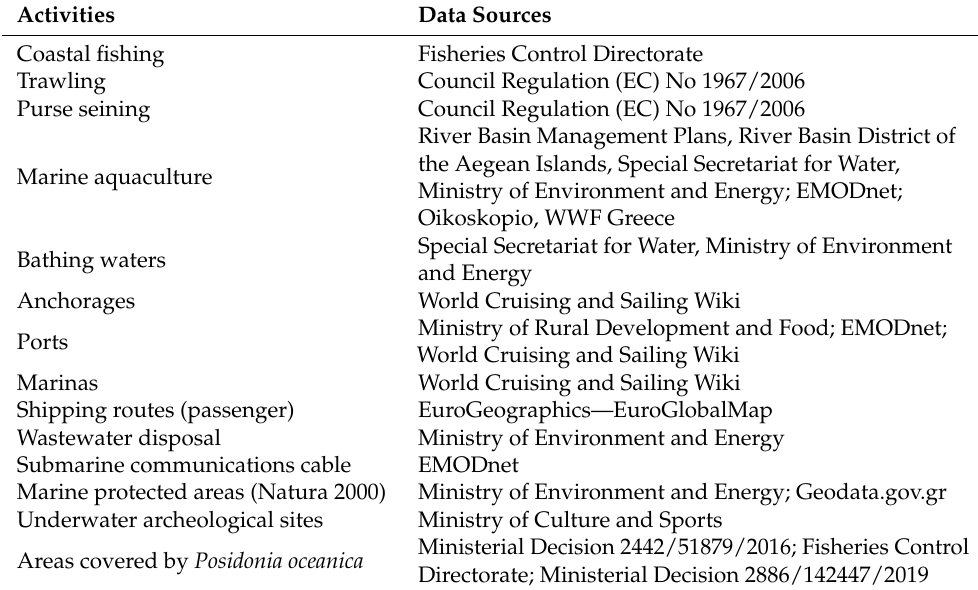
Table 1. The activities in the study area and the relevant data